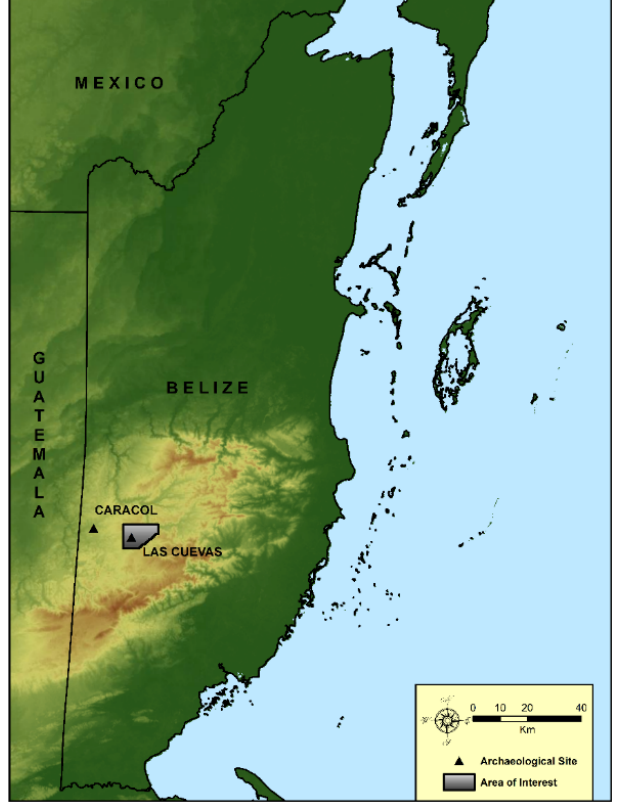
Figure 1. Belize map illustrates location of project area within the Chiquibul Forest Reserve. The Las Cuevas site resides within the present-day Chiquibul Forest Reserve in western Belize near the southeastern extent of the Vaca Plateau (Figure 3), an area of protected land covered by tropical evergreen broadleaf forest [46] (Figure 4). Much of the Vaca Plateau falls within a geologic zone of Cretaceous limestone, with older Paleozoic layers found further west of the site and metamorphic and granitic material located within the Maya Mountains, 20 km to the north [46,47]. Covering more than 1000 km 2 [48], the Vaca Plateau extends east from Guatemala to the Maya Mountains, north to the boundary fault of the Belize River Valley, and south to the gorge of the Chiquibul River. Speleogenesis (cave origin and development) within the Vaca Plateau is associated with structural weaknesses in carbonate breccia derived from the Upper Cretaceous Campur Formation